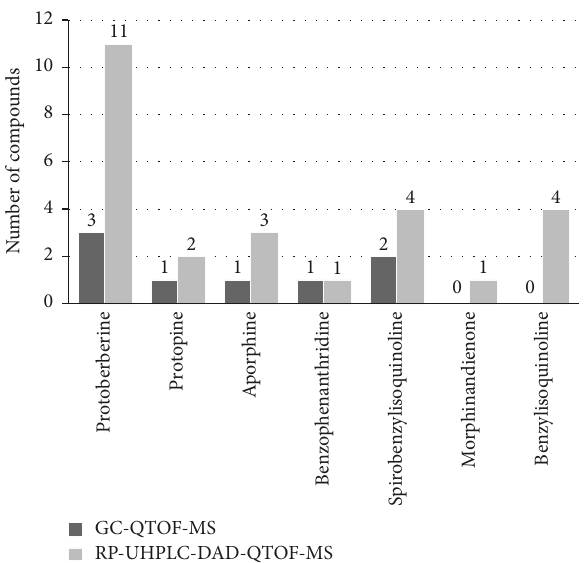
Figure 5: Comparison summary of the qualitative analysis of F. capreolata alkaloids by GC-QTOF-MS and RP-UHPLC-DAD-